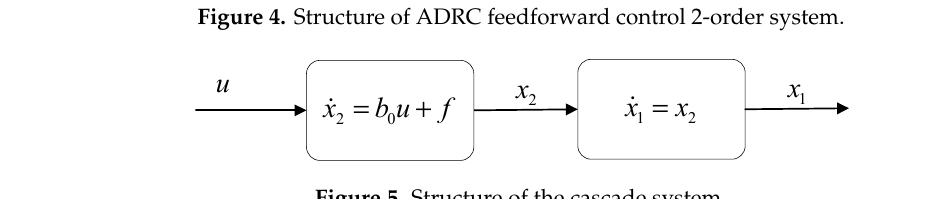
Figure 4. Structure of ADRC feedforward control 2-order system.